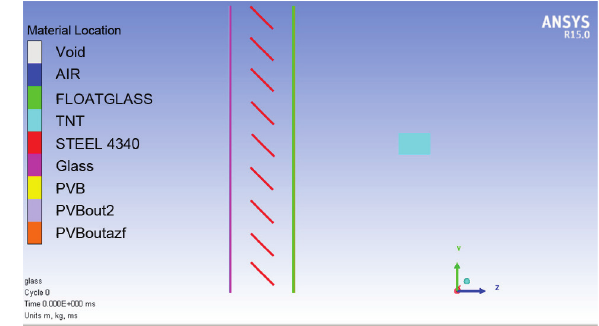
Fig. 6. Lateral face of two-layer laminated glass with steel curtain of 45°